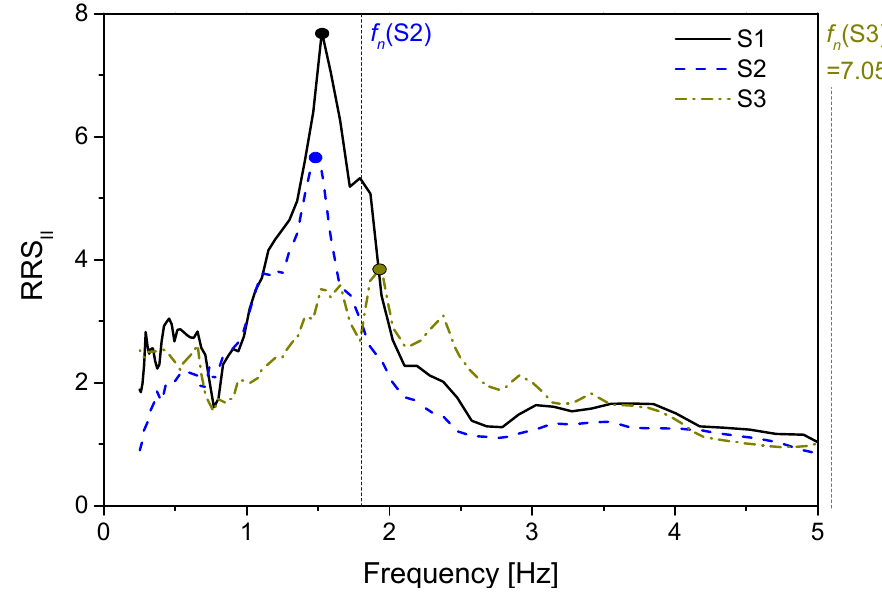
Figure 5. RRS II of S1, S2, and S3 structures with artificial input motion at L_Input intensity. f n and solid circles indicate are fixed‐base frequency and peak RRS of each structure, respectively.